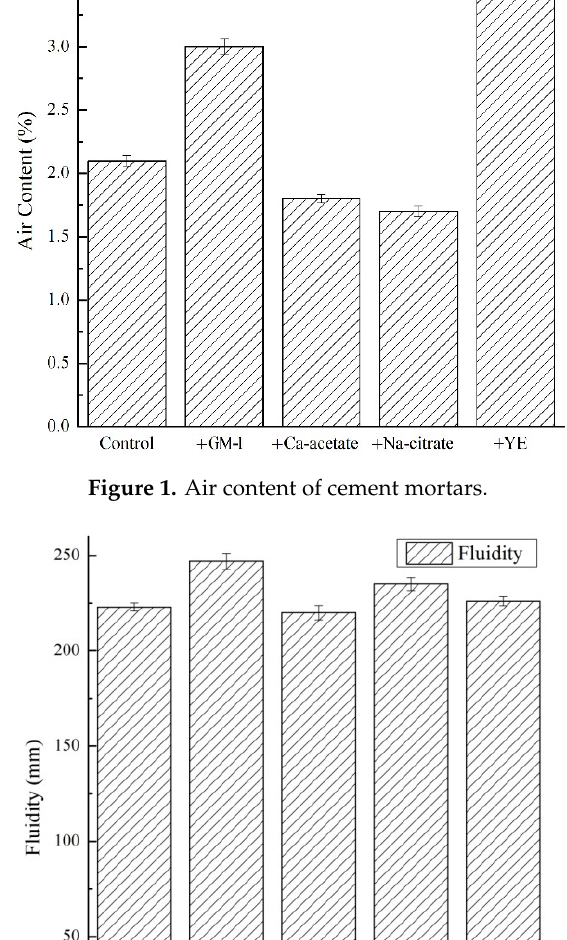
Figure 1. Air content of cement mortars.